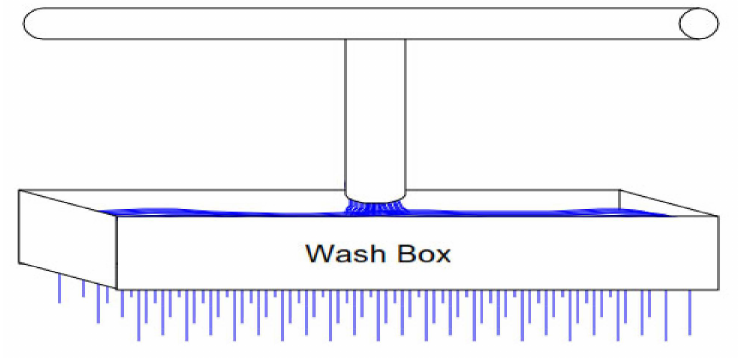
Figure 6. Wash-water box [29].